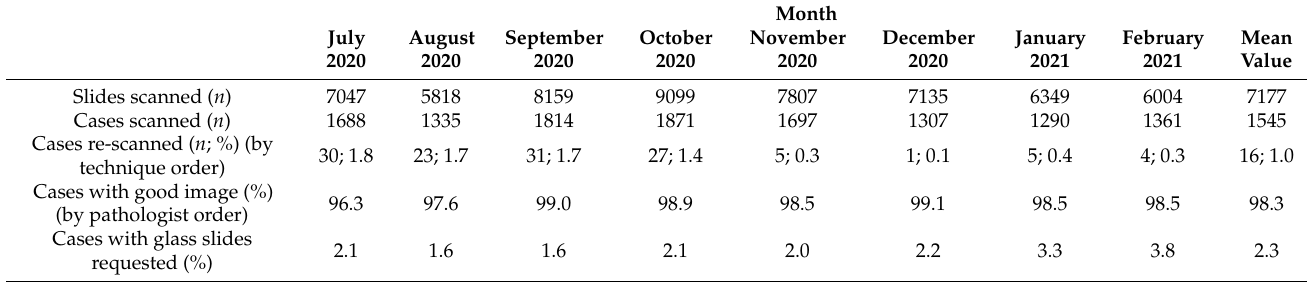
Table 1. WSI bright field results of the 8 months operating fully